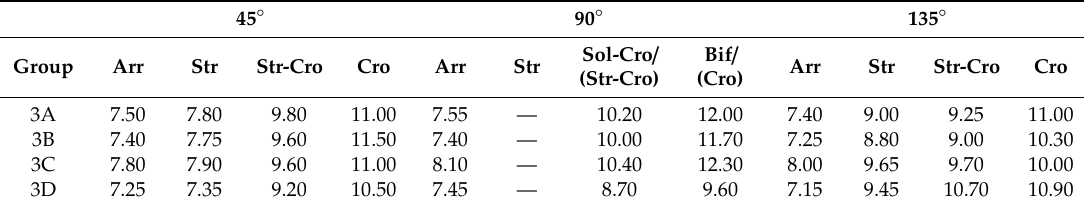
Table 7. Fluid pressure values corresponding to di ff erent in situ stress ratios.